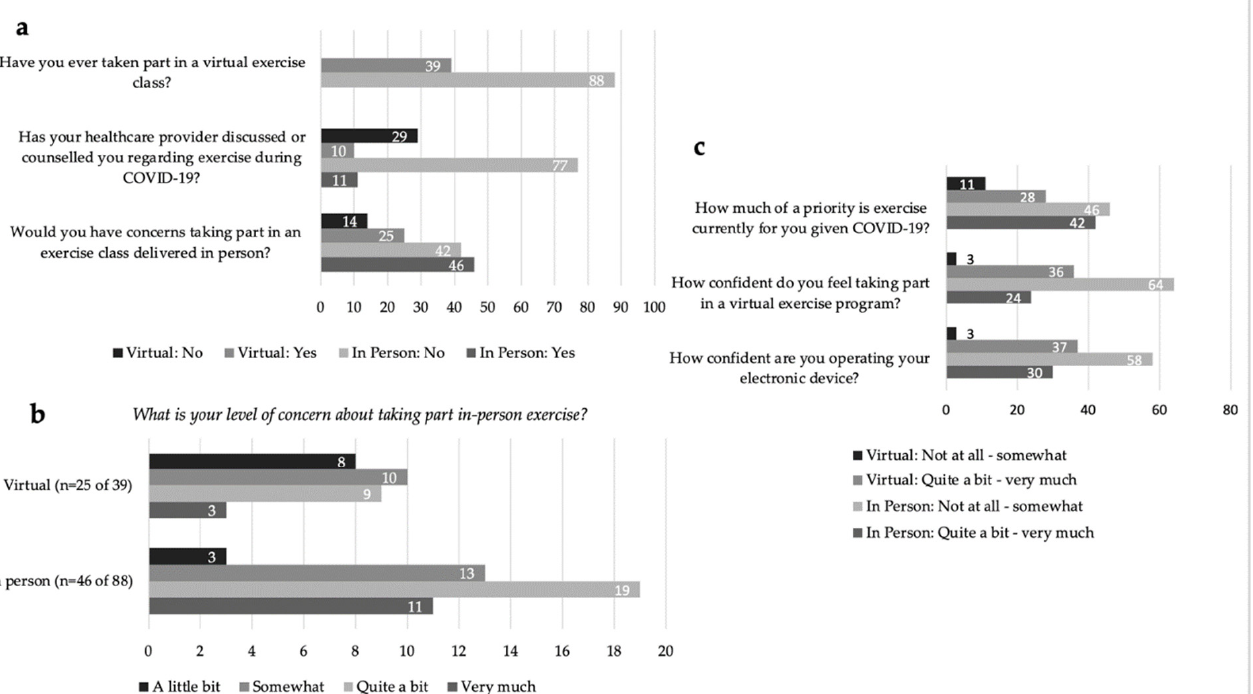
Figure 1. ( a ) Virtual and In-Person exercise preferences and reported exercise counsel by a healthcare professional. ( b ) Virtual and In-Person level of concern regarding in-person exercise in COVID-19. ( c ) Priority of exercise during COVID-19 and confidence ratings accessing virtual exercise and using electronic devices.